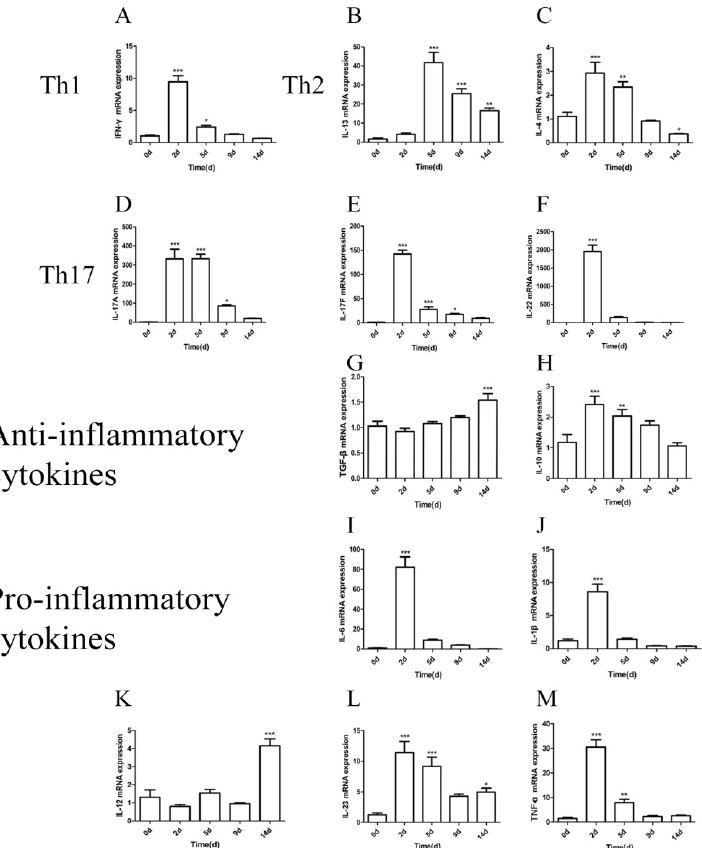
Figure 7. ( A – M ) M. gypseum (4 × 10 6 CFU/mL)-induced expression of cytokines genes (Th1, Th2, Th17, anti-inflammatory cytokines, and pro-inflammatory cytokines) detected by qRT-PCR in the lung after infection on days 2, 5, 9, and 14. Th1: IFN- γ ( A ); Th2: IL-4 andIL-13 ( B , C ); Th17: IL-17A, IL-17F, and IL-22 ( D – F ); anti-inflammatory cytokines: TGF- β and IL-10 ( G , H ); pro-inflammatory cytokines: IL-6, IL-1 β , IL-12, IL-23, and TNF- α ( I – M ).The results are presented as mean ± SD and represent three individual experiments (n = 8 mice per group). * p < 0.05; ** p < 0.01; *** p < 0.001. 2.7. Immune Cells Recruitment following M. gypseum Infection Lung tissue immunofluorescence staining was performed to detect immune cell re- cruitment on 0, 2, 5, and 9 dpi (Figure 8). Immune cells were recruited to the lungs at 2, 5, and 9 dpi compared with day 0. Immunofluorescence staining revealed that large num- bers of PMNs (neutrophils +), DCs (CD11c+), and macrophages (CD54+) were recruited to the alveoli septa and bronchi of M. gypseum infected mice. Accordingly, these immune cells were scarce in the lungs of control mice. These results suggest that forceful pulmo- nary innate immune responses were induced during M. gypseum infection.